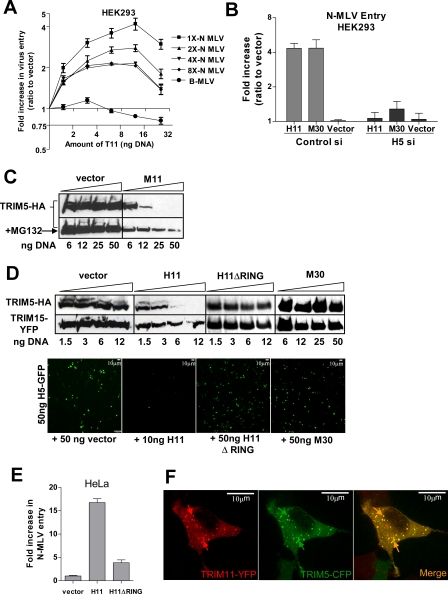
TRIM11 Reduces the Protein Levels of TRIM5(A) Effects of increasing amounts of transfected plasmid encoding human TRIM11 on entry of B-MLV and increasing amounts of N-MLV.(B) The effects of transient expression of TRIM11 (10 ng DNA transfected), TRIM30 (50 ng DNA transfected), and empty vector (Vector) on N-MLV entry were tested in HEK293 cells treated with either control (control si) or TRIM5 specific siRNA (H5 si).(C) Western blot (anti-HA serum) of HEK293 cells 48 h after transfection with plasmids encoding HA-tagged TRIM5 and either increasing amounts (ng DNA) of empty vector (pcDNA) or a plasmid expressing mouse TRIM11 (M11). Cells were treated with the proteasome inhibitor MG132 (10 μM) for 6 h prior to analysis as indicated.(D) An experiment as in (C) for cells expressing HA-tagged TRIM5 or TRIM15-YFP together with human TRIM11 (H11), its mutant lacking the RING domain (ΔRING) and mouse TRIM30 (M30). The lower panel shows the parallel TRIM5 GFP-levels in cells.(E) Fold increase in N-MLV entry in the HeLa cells expressing either control plasmid, wild-type human TRIM11, or its RING domain mutant (ΔRING).(F) TRIM11-YFP (5 ng, red) and TRIM5-CFP (50 ng, green) were transfected into HEK293 and the localization of both proteins monitored by confocal microscopy 24 h post-transfection.